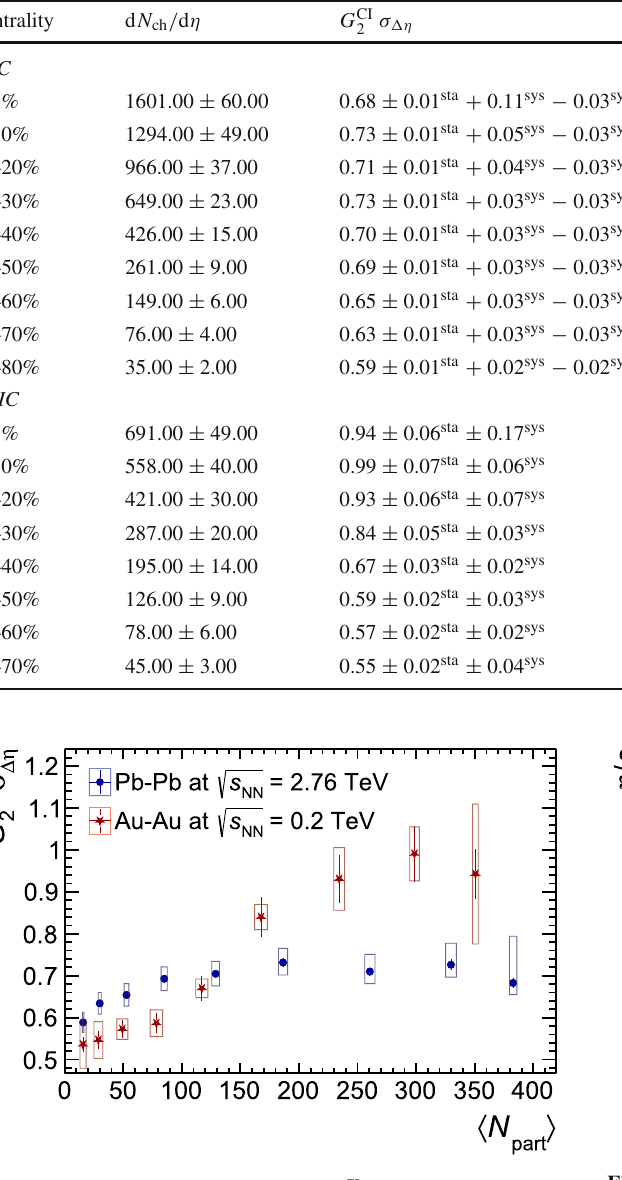
Computed values of η/ s range from 0 . 04 ± 0 . 02 sys